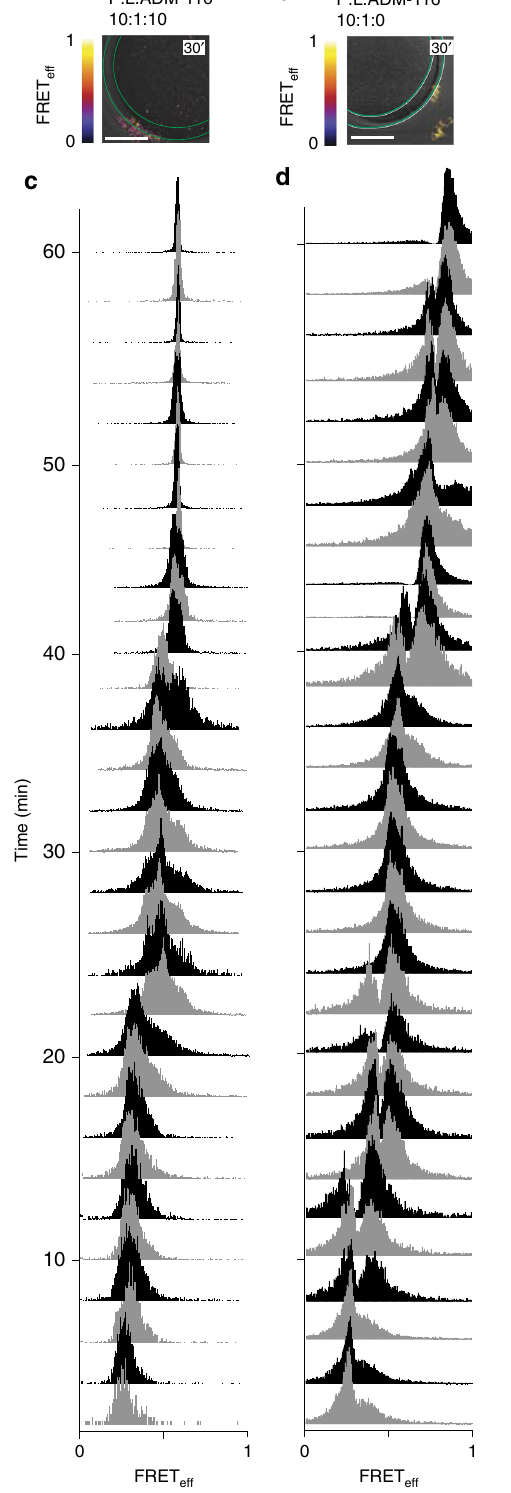
ciently de fi ned as to be addressable with a protein-speci fi c ligand. phase transitions.